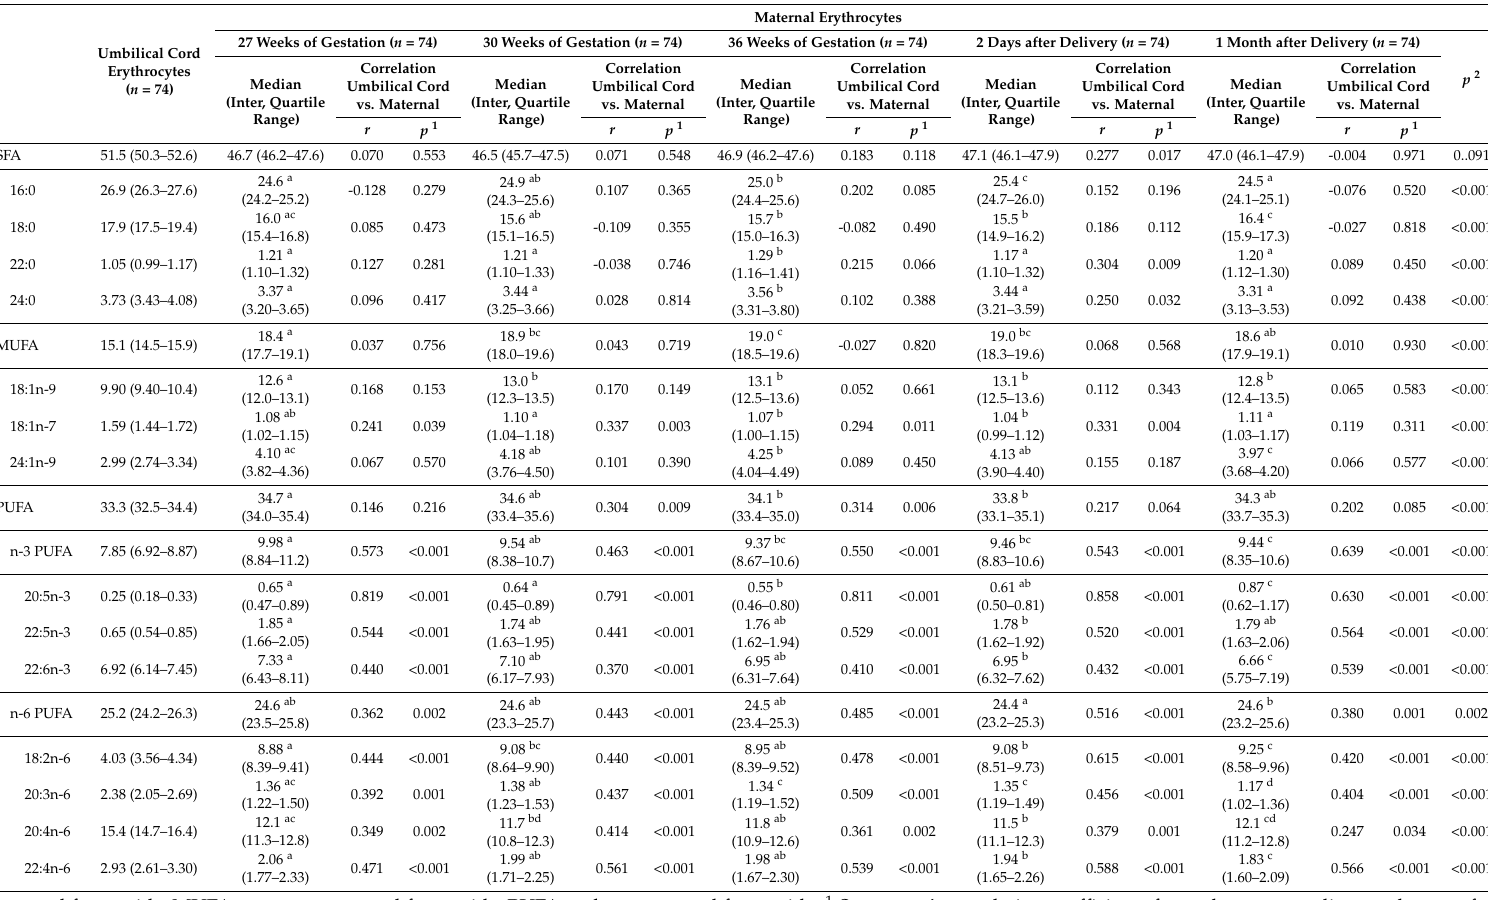
Table 2. Fatty acid levels (% of total fatty acids) in umbilical cord and maternal erythrocytes and the correlation coefficients for each corresponding erythrocyte fatty acid between umbilical cord and maternal erythrocytes at 27, 30, and 36 weeks of pregnancy and 2 days and 1 month after